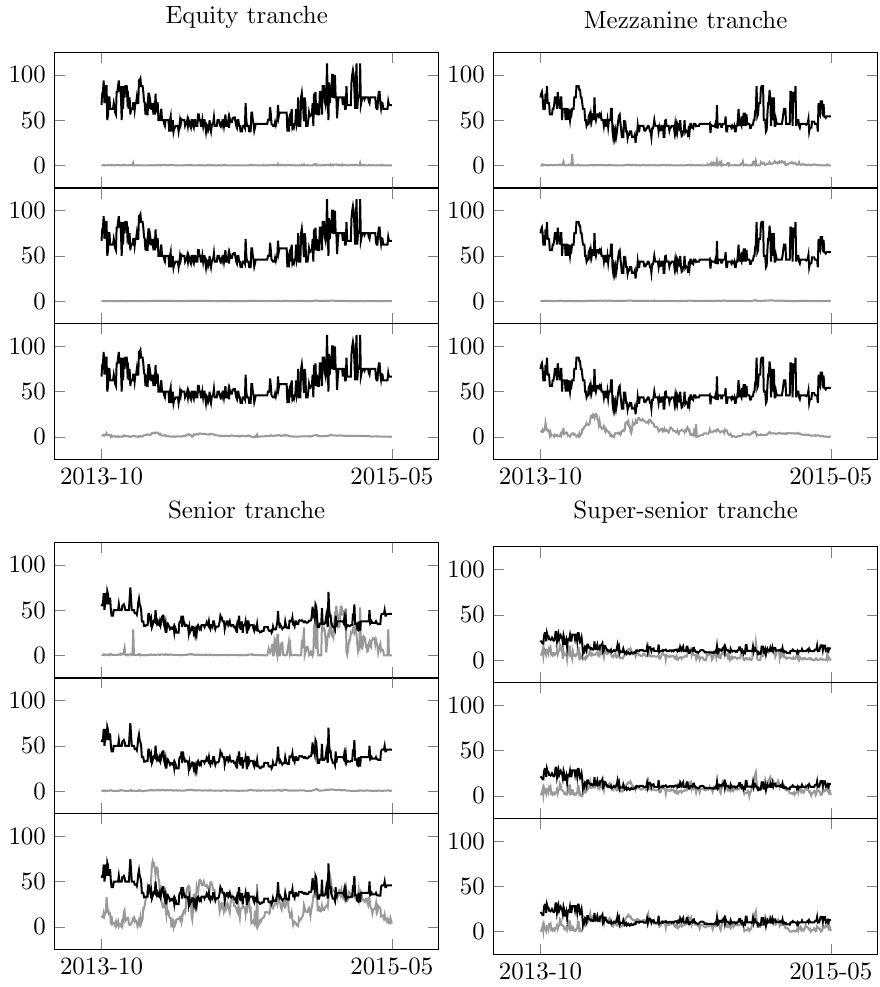
Figure 11: Diagnostic of models calibrated on CDX.NA.IG.21 tranches. Time-series are displayed in basis points with the bid-ask spread (black) and the pricing errors (grey) for the model with either threeparameters( w , ρ 1 , ρ 2 )andBeta-Binomial(top)orzero(middle)recovery,ortwoparameters( w , ρ 1 , 0.99)andzero-recovery